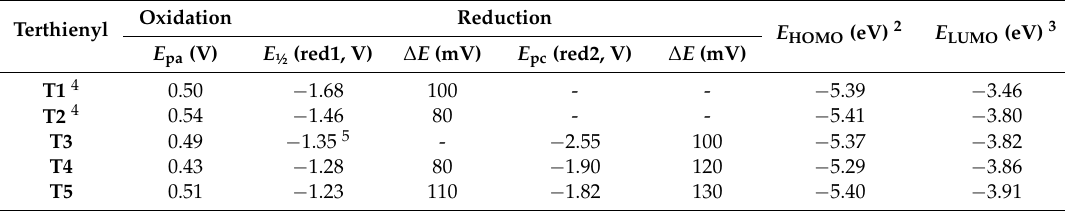
Table 2. Electrochemical data for thieno[3,4- b ]pyrazine-based terthienyls T1 – T5 . 1